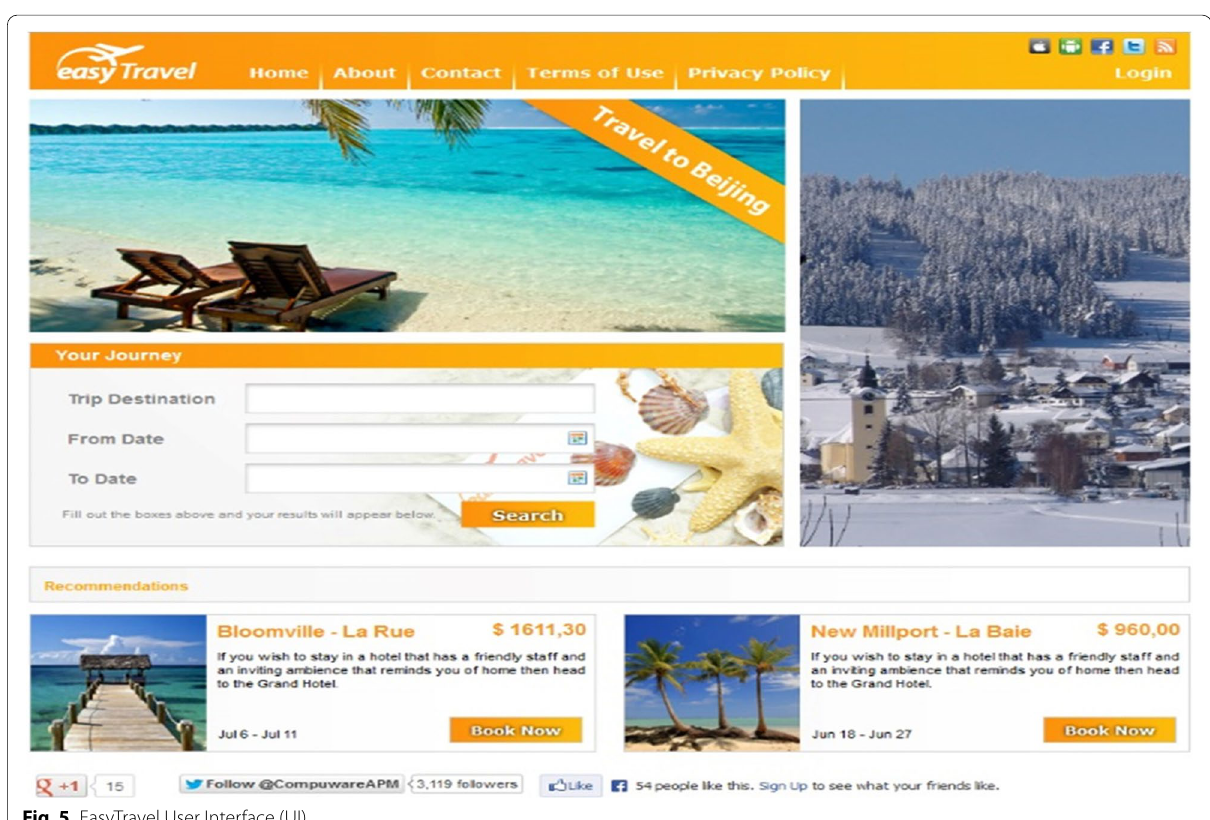
Fig. 5 EasyTravel User Interface